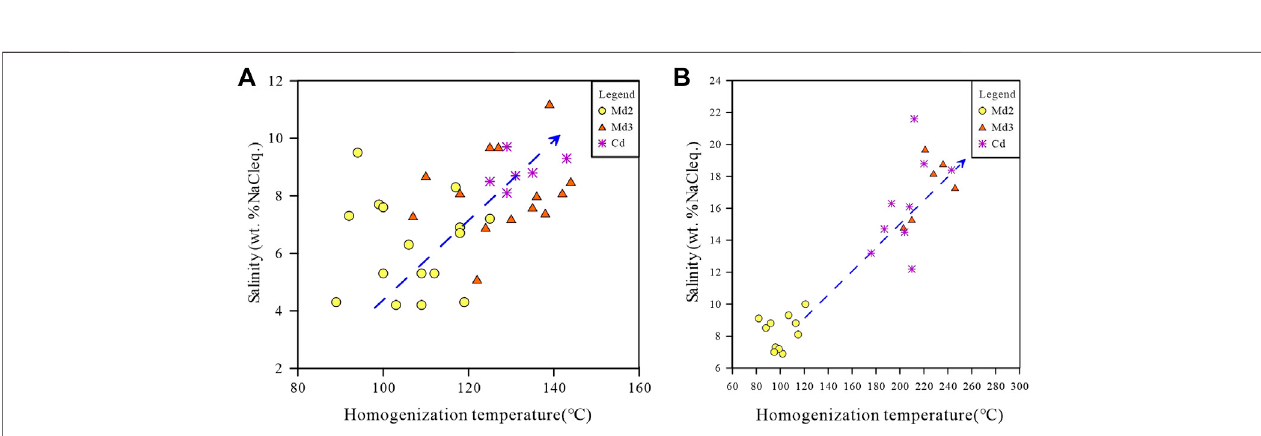
Frontiers in Earth Science |